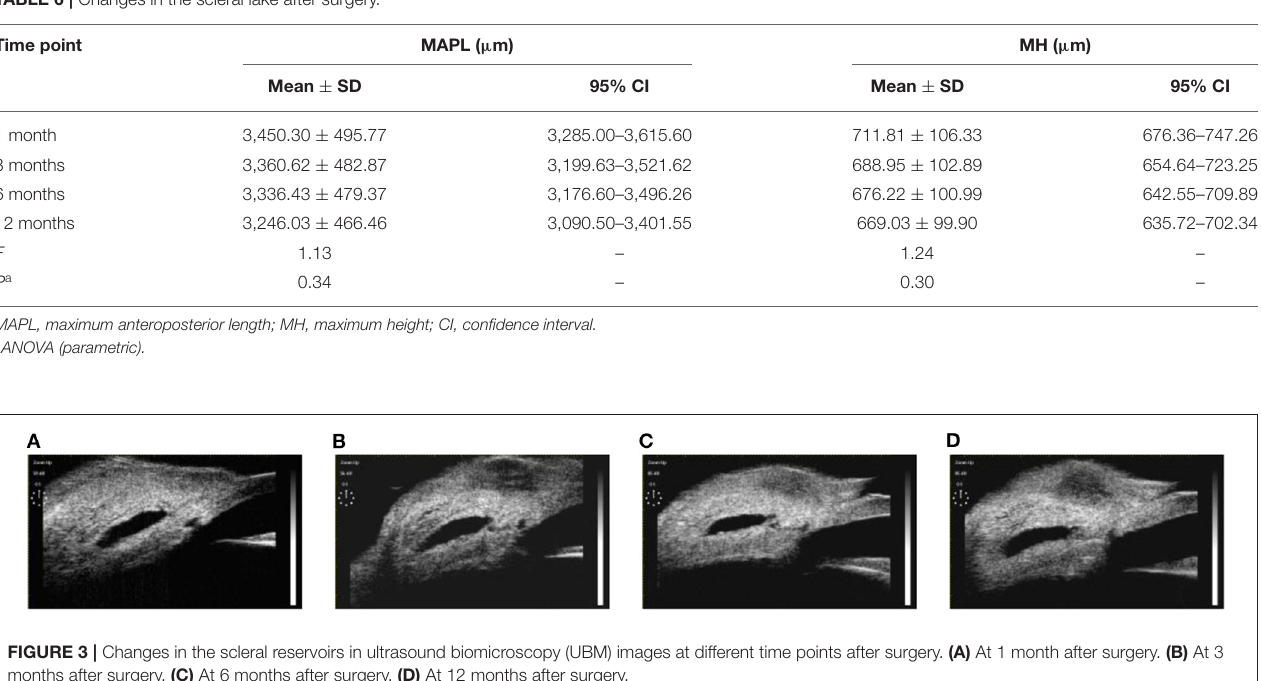
Frontiers in Medicine |